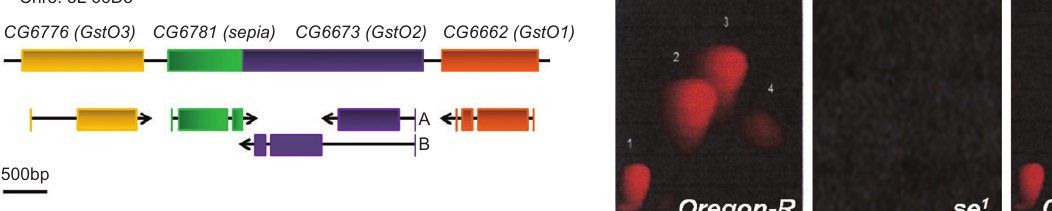
Figure 2 Transgenic GSTO expression Drosophila rescues eye color defect in sepia mutants.